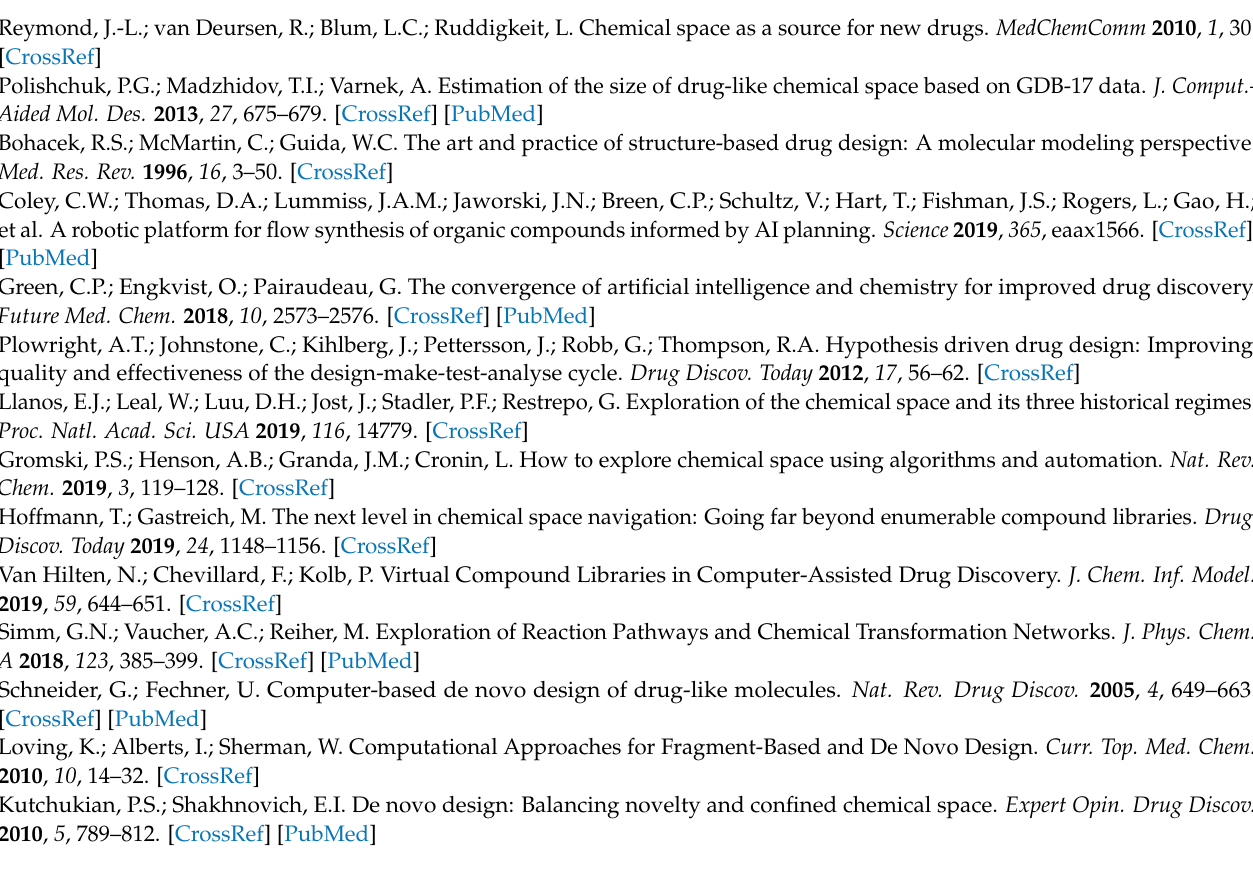
Figure S9: Physicochemical properties distribution of Subset (SRP:2); Figure S10: Physicochemical properties distribution of Subset